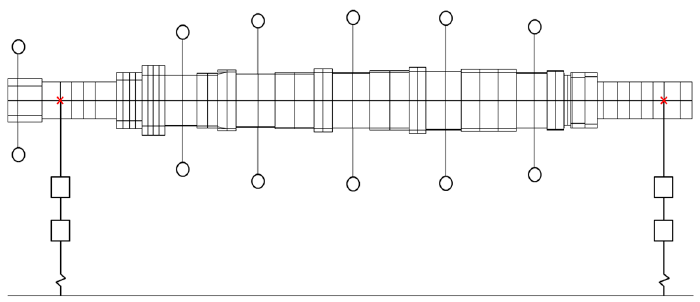
Figure 39. Dummy rotor rotordynamic model.